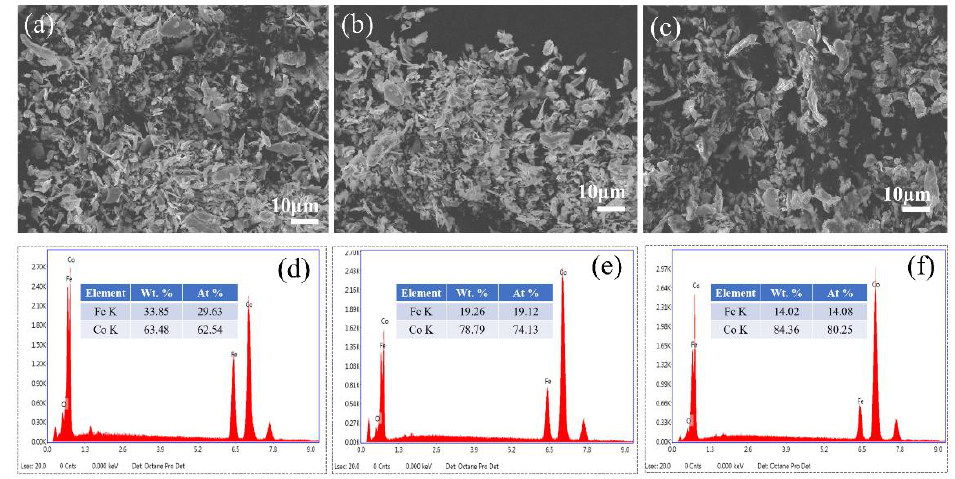
Figure 2. SEM image and EDS spectrum of Fe 35 Co 65 ( a , d ), Fe 22 Co 78 ( b , e ), Fe 15 Co 85 ( c , f ).